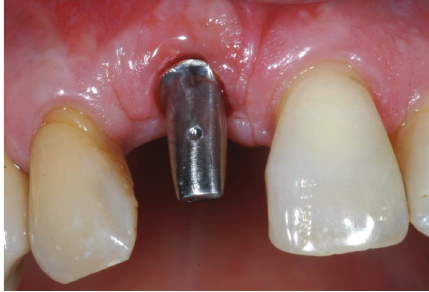
Figure 17: Two weeks after implant placement, a standard prefab- ricated, prepared, and finished titanium abutment was placed and activated.